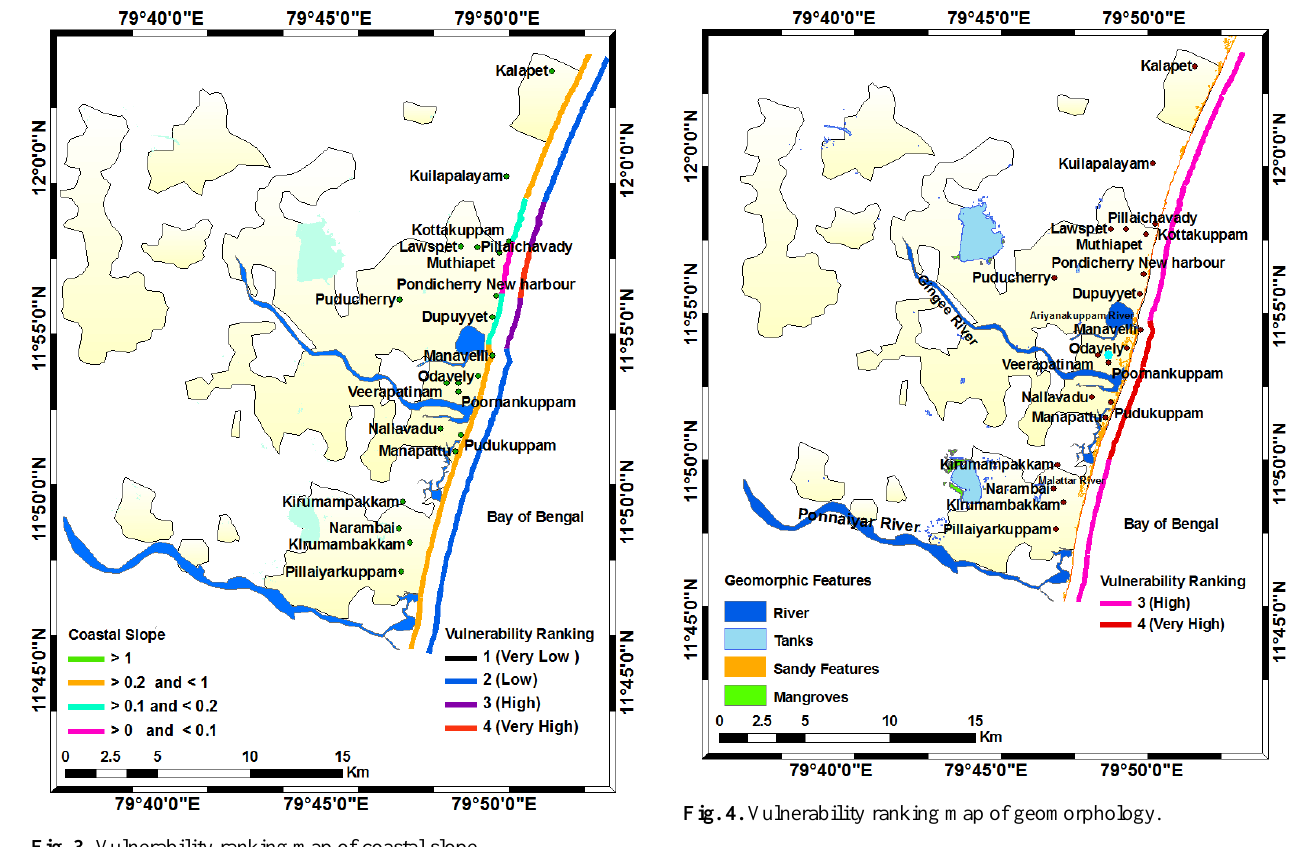
Fig. 3. Vulnerability ranking map of coastal slope.